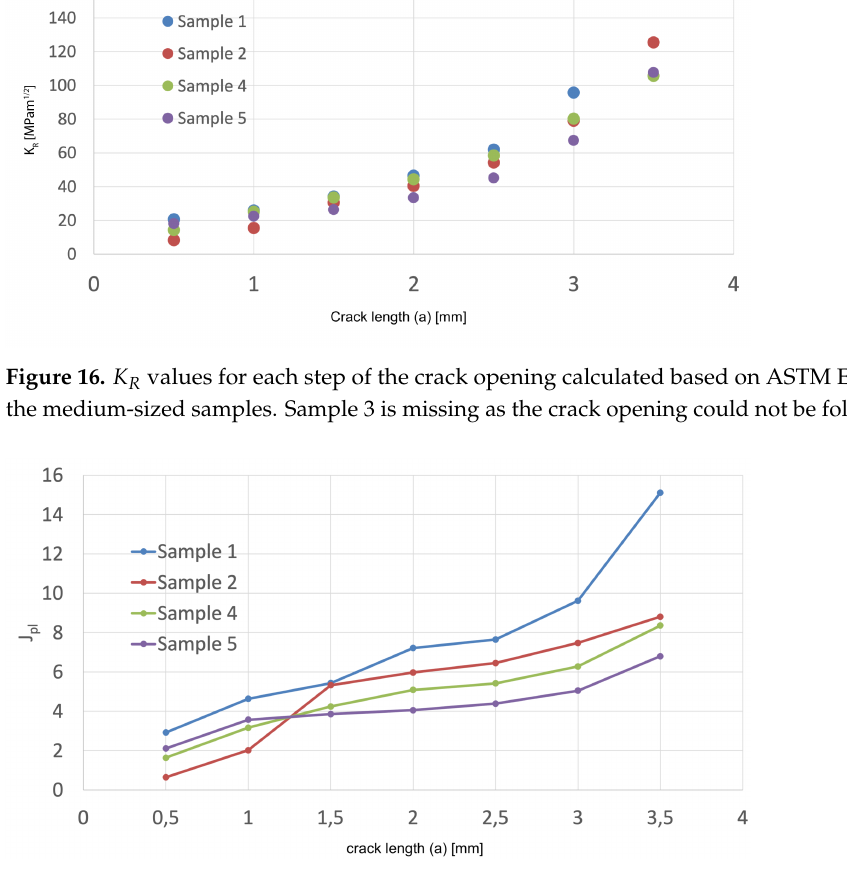
Figure 17. J pl for the medium-sized samples calculated based on the sample parameters and the crack opening similar to Figure 15.